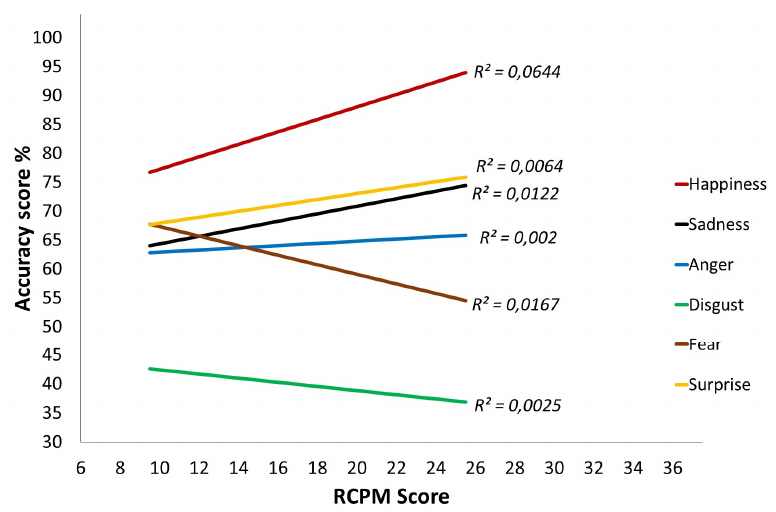
Figure 4. Cross-sectional developmental trajectories for the six basic emotions over Raven’s Colored Progressive Matrices (RCPM) scores, Down syndrome (DS) group.